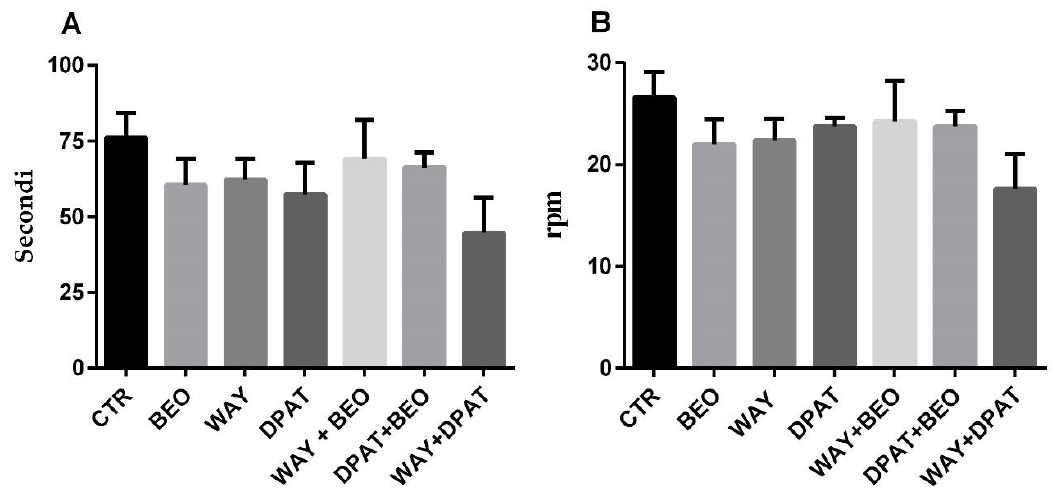
Figure 6. Time (A) and rpm (B) in rotarod in male Wistar rats after systemic (i.p.) administration of jojoba oil (CTR) (500 µL/kg), Bergamot Essential Oil (BEO) (500 µL/kg), WAY100635 (WAY) (1 mg/kg), 8-OH-DPAT (DPAT) (1 mg/kg), WAY + BEO (1 mg/kg + 500 µL/kg), DPAT + BEO (1 mg/kg